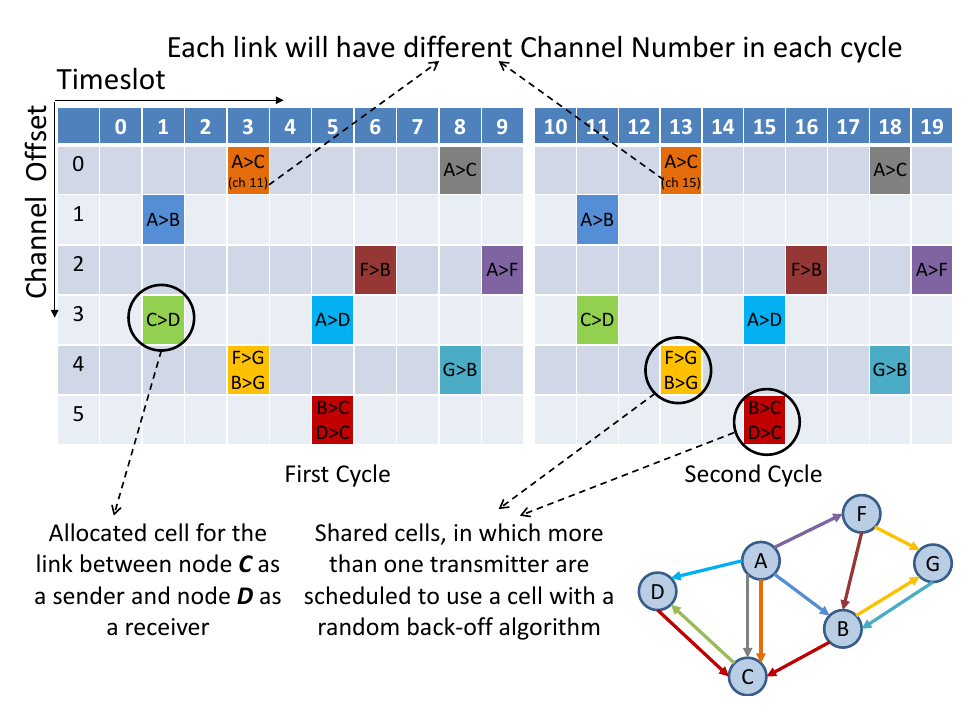
Figure 1. Time Slotted Channel Hopping (TSCH) slot-channel matrix for a sample